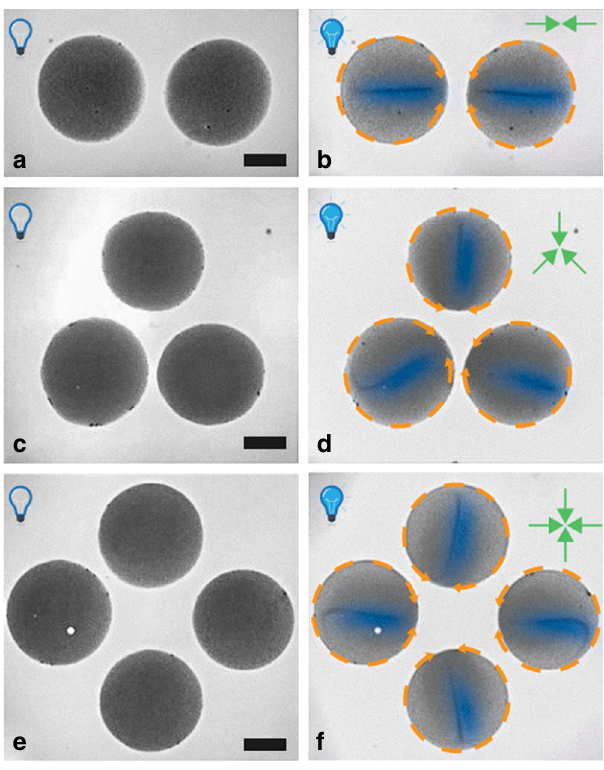
Fig. 3 Alignment of the vortical fl ows in ensembles of active drops. Transition, upon illumination with UV light, from a uniform distribution of particles inside each drop (left column) to a steady hydrodynamic fl ow (schematically indicated by the dashed orange arrows), accompanied by the collective motion of the CAP within each drop (right column). The drops are arranged in regular, polygonal con fi gurations. The panels on the right side illustrate the emergent alignment of the directors d of the drops: they point towards the geometrical center of the corresponding polygon, without any noticeable fl uctuations in time. (For visual clarity, the region around a director is shaded in blue in accordance with the observed gray scale density.) The inset green arrows schematically depict the theoretically expected arrangement of the directors (see the main text). The scale bar corresponds to 100 μ